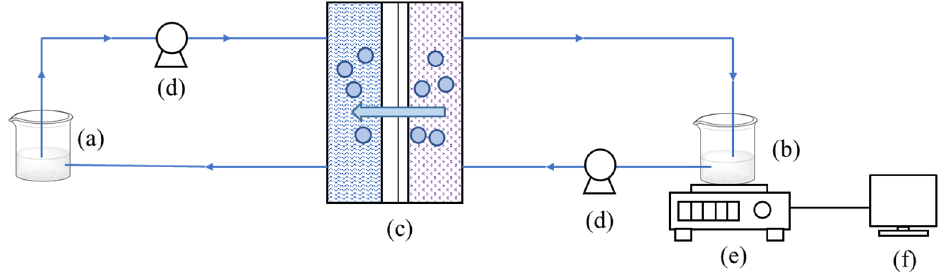
Figure 1. FO concentration process. ( a ) Draw solution; ( b ) Feed solution; ( c ) FO membrane module; ( d ) Peristaltic pump; ( e ) Digital balance; ( f ) Computer.